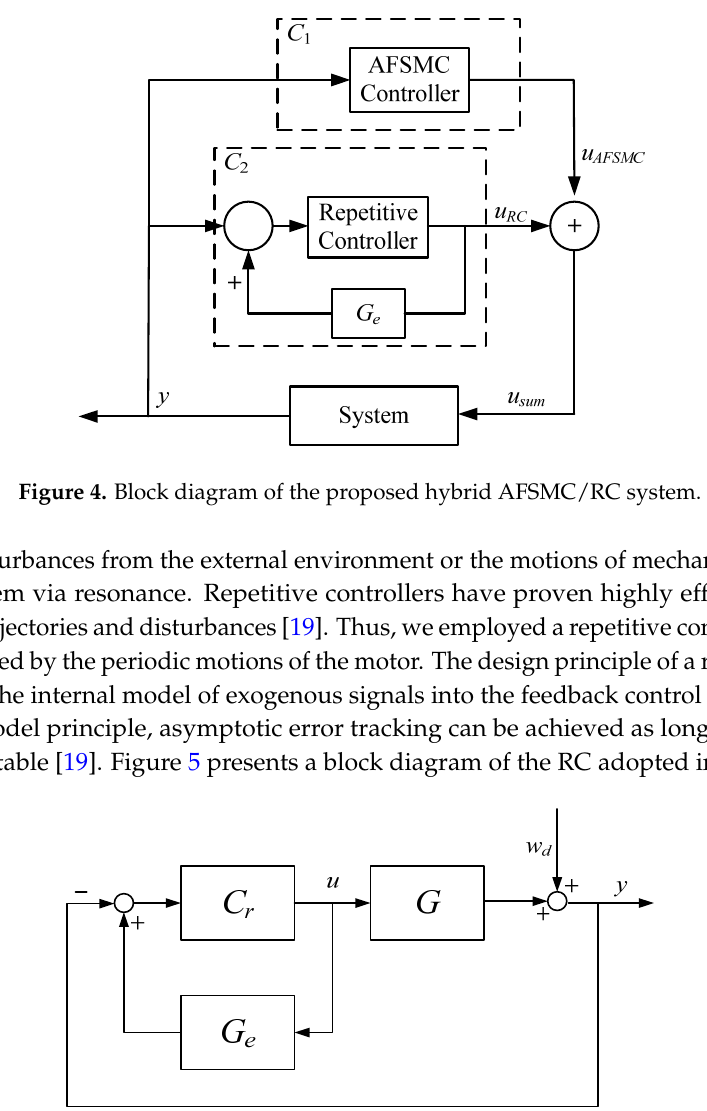
Figure 5. Block diagram of the applied repetitive control system.